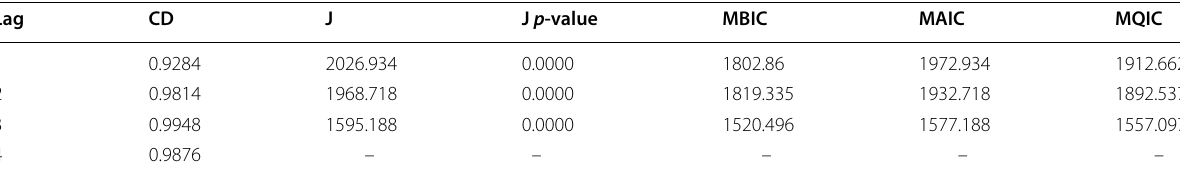
Table 6 Lag order selection criteria